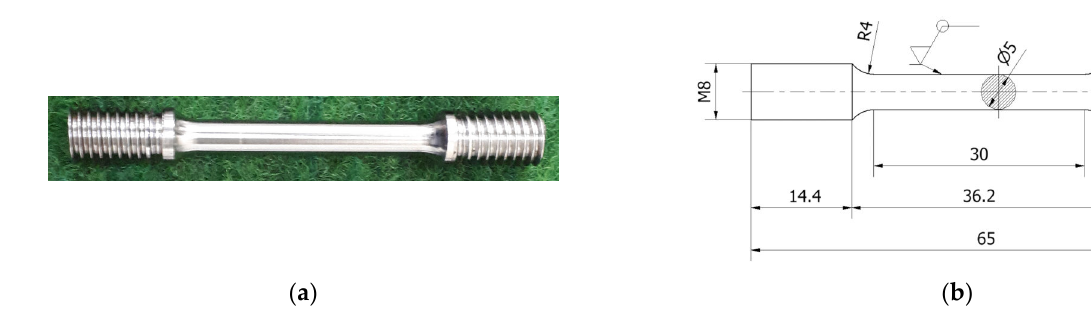
Figure 2. Specimen of Armstal 550 steel: ( a ) a photo of a specimen; ( b ) a technical drawing.